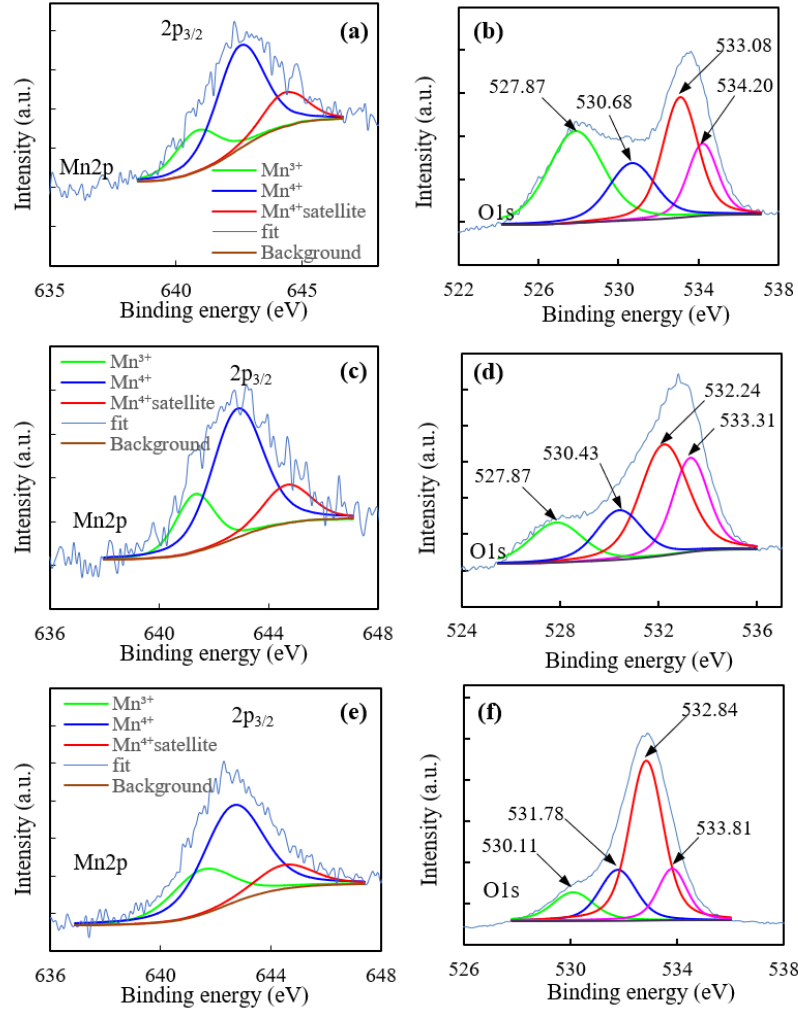
Figure 5. Mn2p and O1s XPS spectra for the Mn 90.8 Cu 9.2 /SiO 2 –EMD ( a , b ); Mn 90.6 Cu 9.4 /SiO 2 –SARA ( c , d ); and Mn 90.9 Cu 9.1 /SiO 2 –WI ( e , f ) catalysts calcined at 350 °C for 3.5 h.